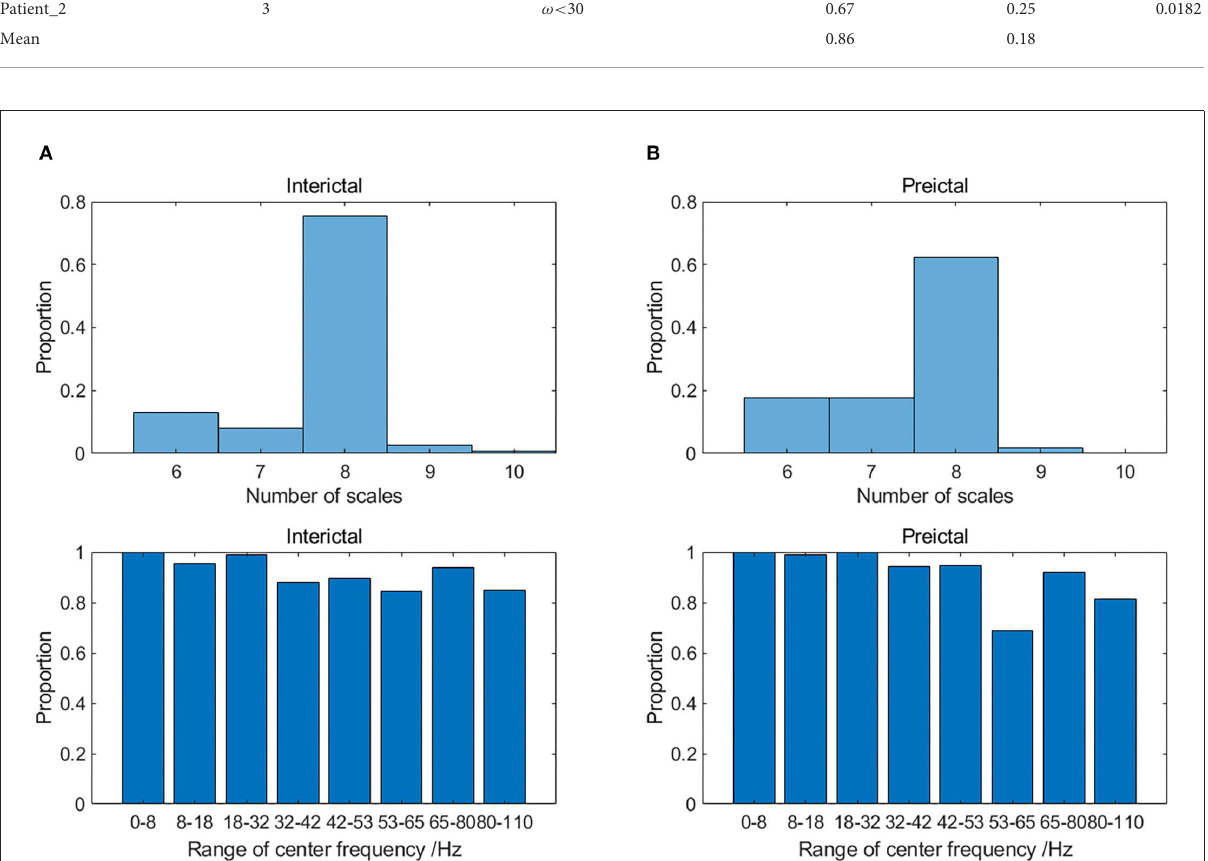
FIGURE3 The distribution of the number of time scales (upper) and range of center frequency on 8 dominant scales (lower) in (A) interictal and (B) preictal states for Dog_5.